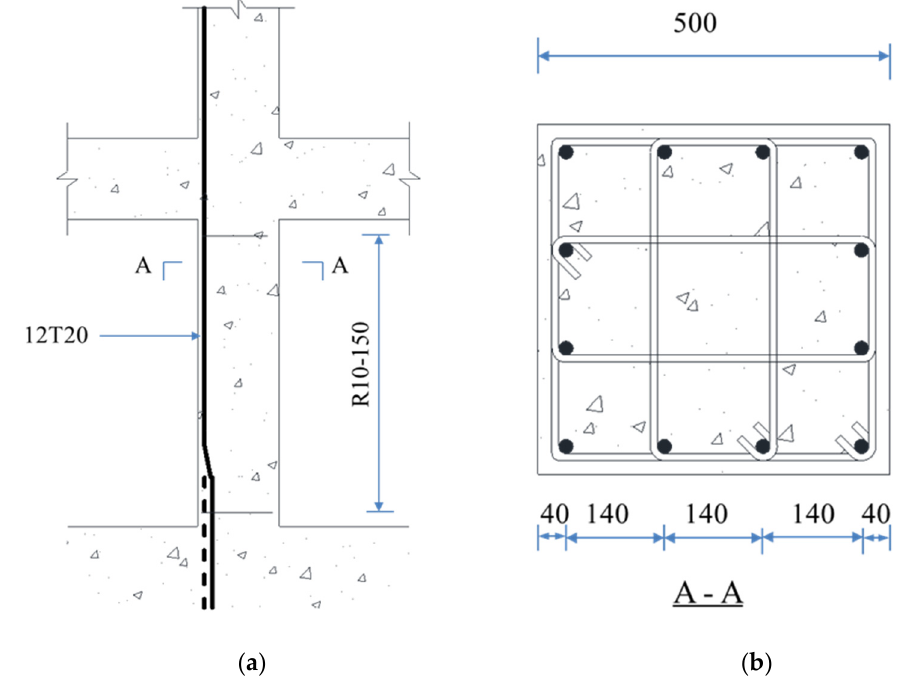
Figure 10. Reinforcement details of column: ( a ) front view; ( b ) plane view.